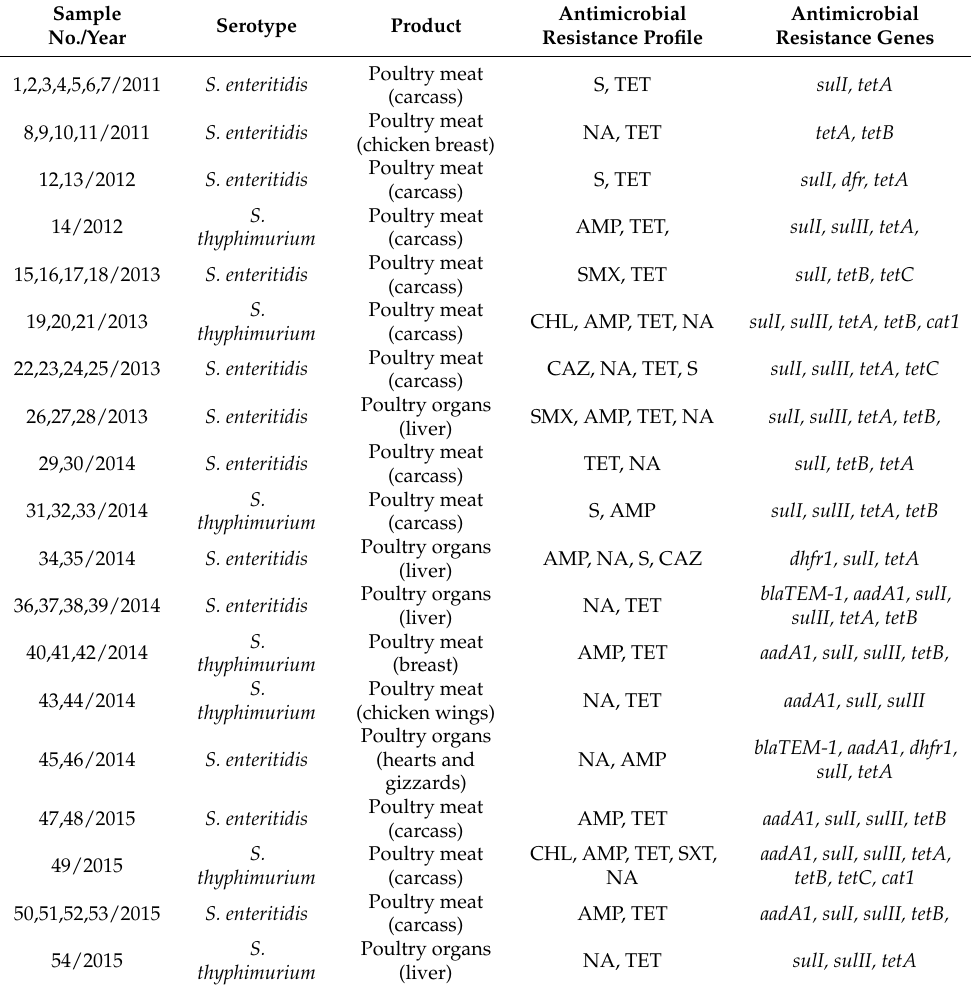
Table 1. Antimicrobial susceptibility of Salmonella isolates in poultry meat and poultry meat products in the period 2011–2015